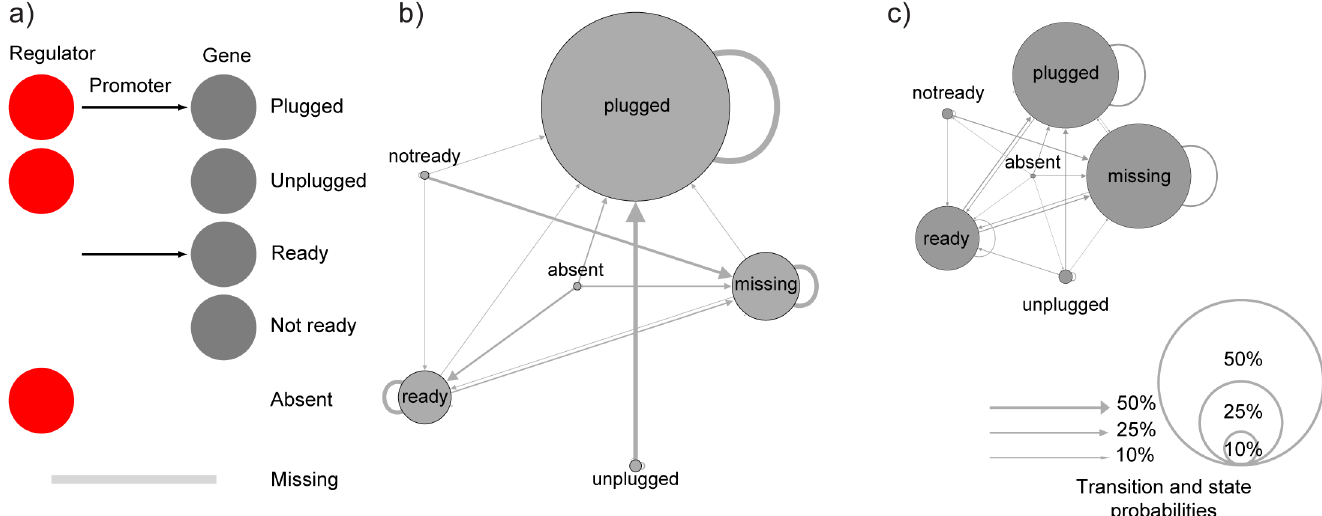
Fig 4. Regulatory network dynamics. a) Graphical representation of the six states in which each regulatory link (a gene found with a TFBS in at least one genome) can be found in the S. meliloti species and between the outgroup species; b) states probabilities and states transitions probabilities inside the S. meliloti species: nodes and edges sizes are proportional to the probability in the model. For each state, the sum of transition probabilities is one; transition probabilities below 0.1 are not shown; c) states probabilities and states transitions probabilities between the outgroup species.